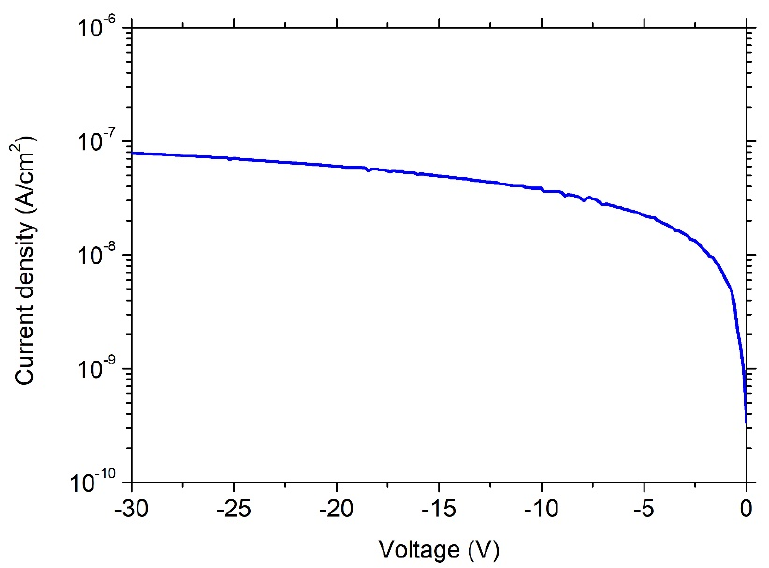
Figure 2. Current density vs. voltage characteristic at RT in forward bias from 0 to 3 V, in dark conditions. The insert reports the J–V characteristic in linear scale.